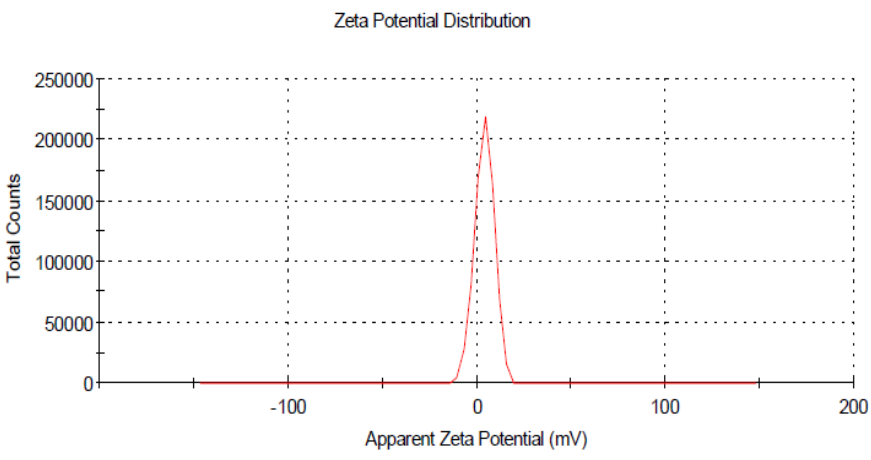
Figure 5. Zeta potential for Glycyrrhizic acid nanoparticles.